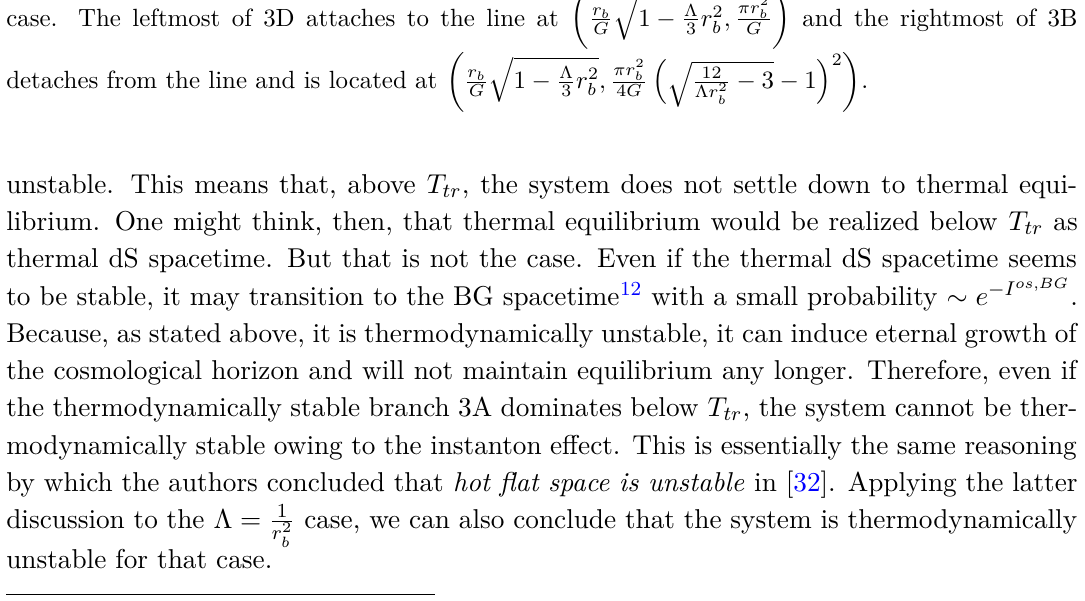
Figure 7 . Qualitative behaviors of entropy for 0 < Λ < 3 entropy bound S = πr 2 b leftmost of 3D is at of Λ , the endpoints of the two branches meet on the entropy bound line. ( Bottom ) 1 case. The leftmost of 3D attaches to the line at detaches from the line and is located at